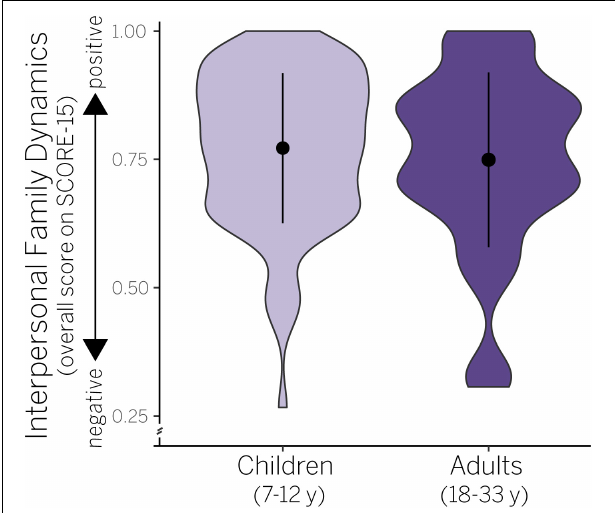
FIGURE 1 | Violin plots showing probability density (width of shaded data) and mean/SD (black circle, vertical bar) in interpersonal family dynamics in children and adults. Raw scores are plotted ranging from 0 (negative) to 1